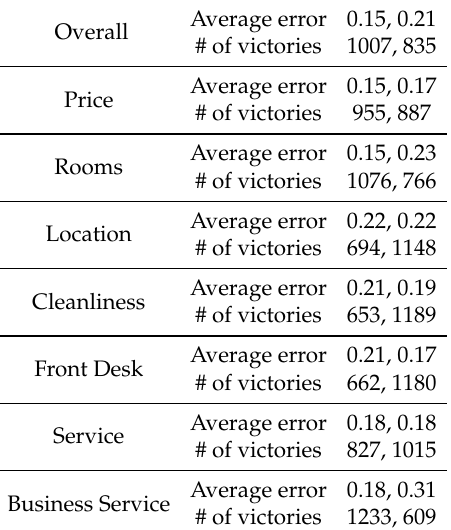
Table 17. # victories and average rounding error, k in